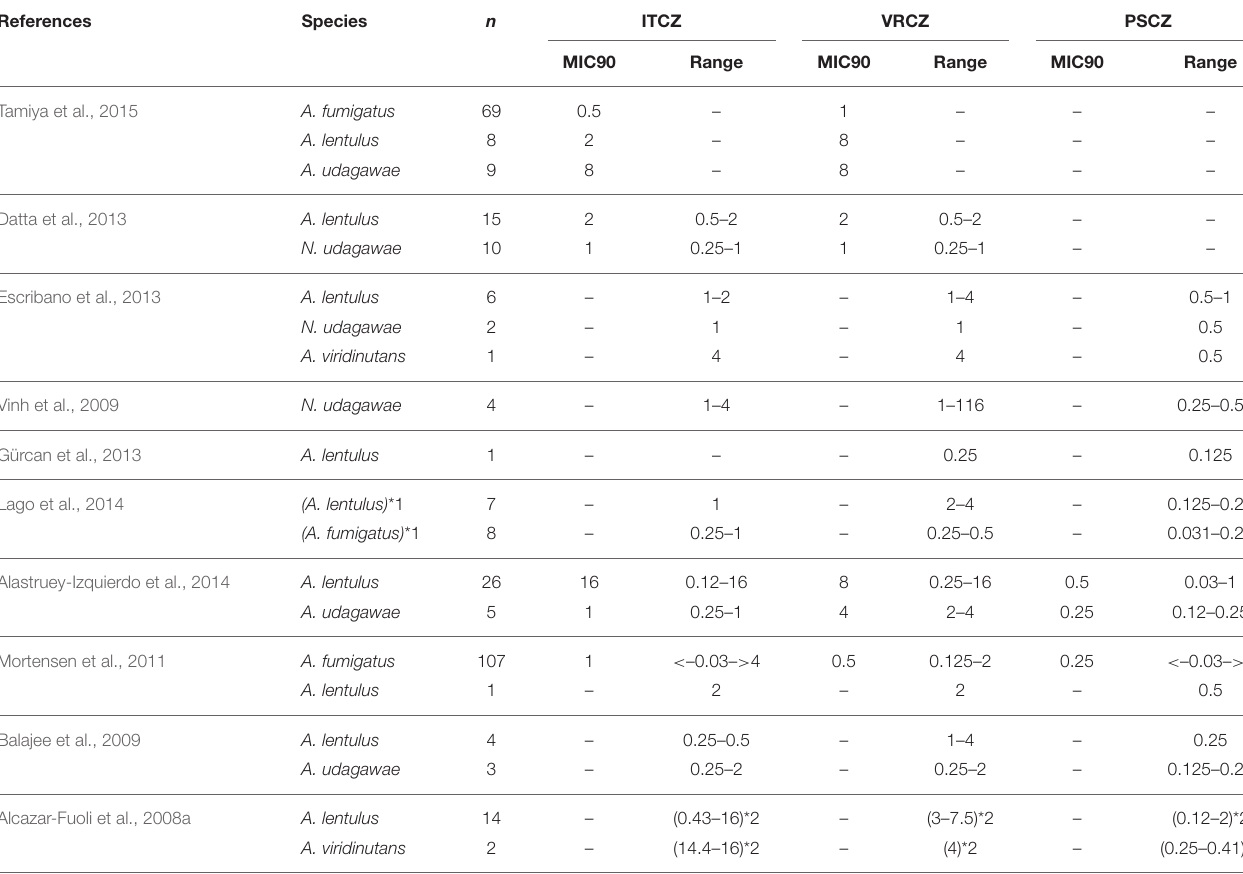
TABLE 3 | Summary of the MICs for Aspergillus section